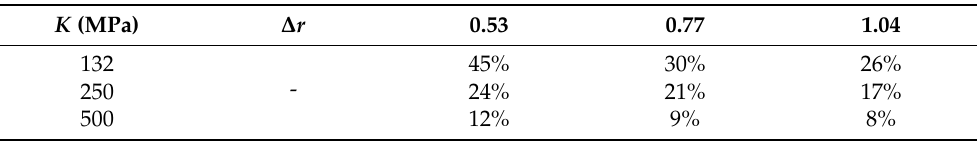
Figure 19. Results of ( a ) earing height and ( b ) % earing height profiles in a comparison between uniform and varying BHFs for a highly anisotropic sheet material of AA2090-T3. Table 4. Effect of strength coefficient ( K ) and planar anisotropy ( ∆ r ) on the reduction of earing height variation by using the varying BHF.